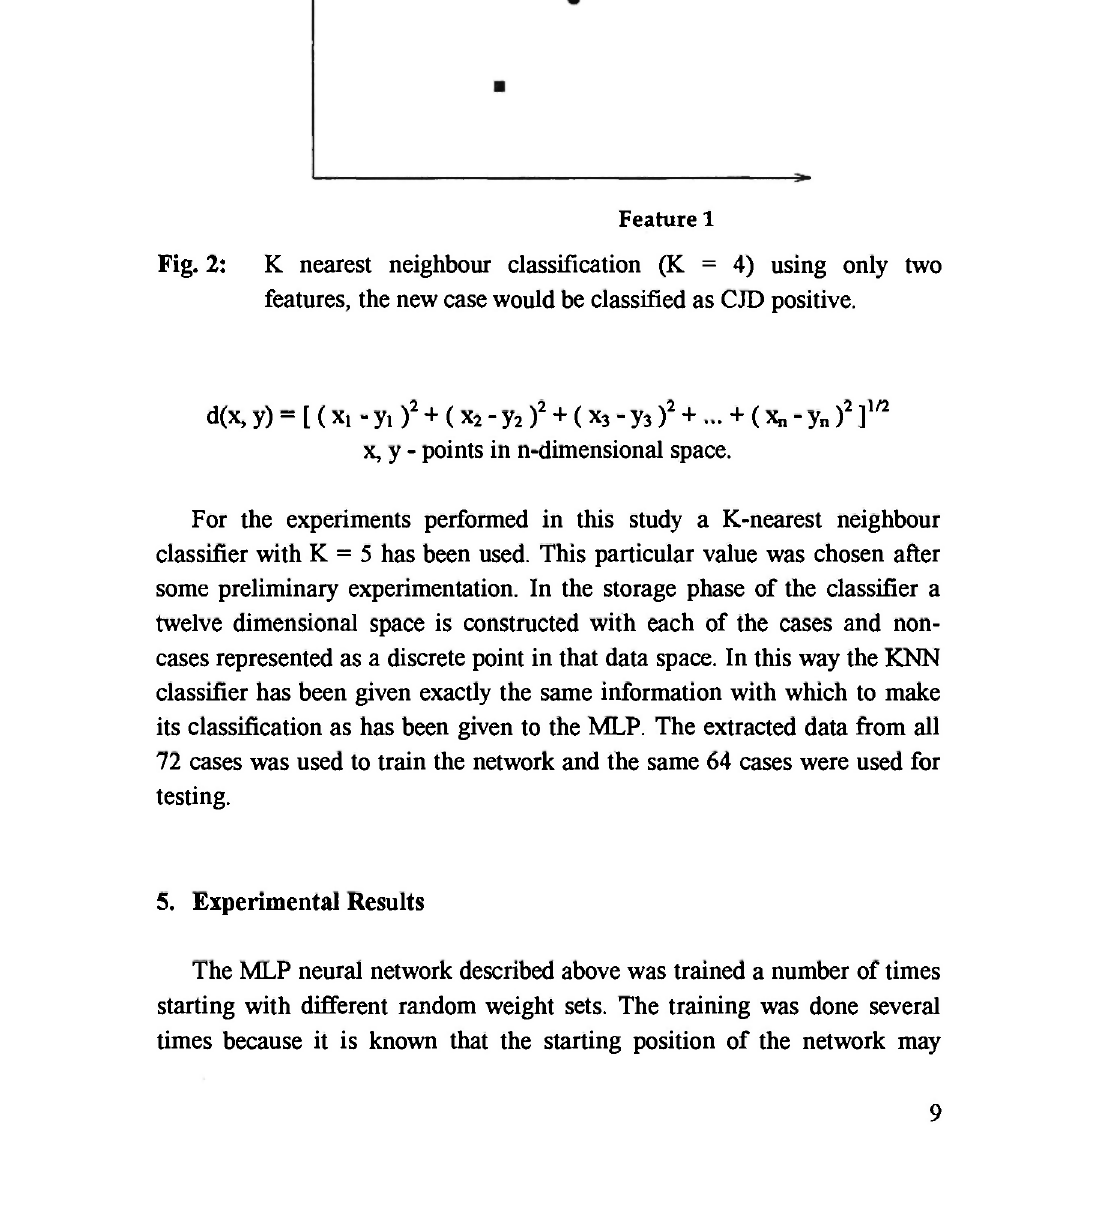
Fig. 2: Κ nearest neighbour classification (Κ = 4) using only two features, the new case would be classified as CJD